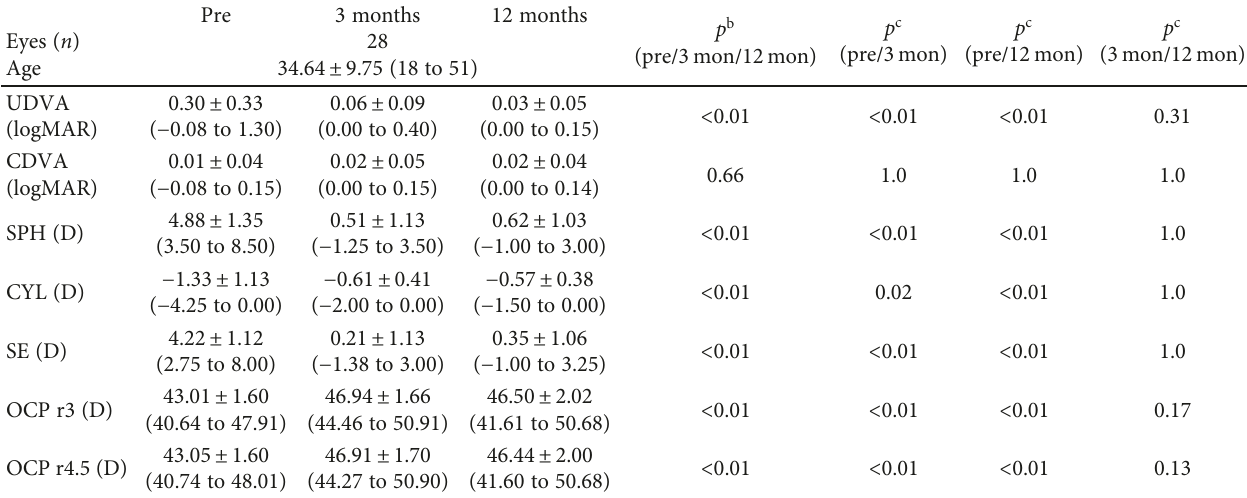
Table 3: Preoperative and postoperative visual, refractive and objective outcomes 12 months after hyperopic LASIK a,b,c (group 2, SE >